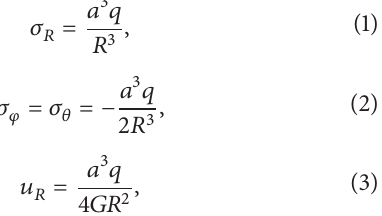
cavity to point 𝑝 , and 𝑅 2 is the distance from the image to point 𝑝 . 𝜑 1 and 𝜑 2 are the angles from 𝑟 direction to 𝑅 1 and 𝑅 2 ,